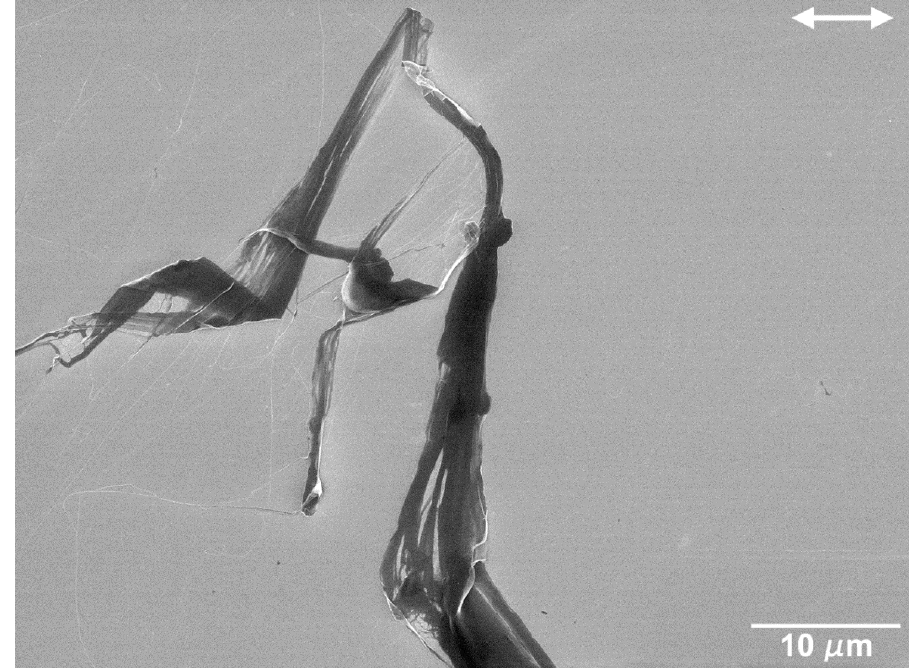
Figure 6. SEM micrographs of the centre of wear tracks on the polished Si specimen performed at 25 mN. ( a,b ) General views of the wear track at different magnifications. ( c ) Detail of the transferred PTFE lump. ( d ) Loosely adherent PTFE film. The double arrow indicates the sliding direction.